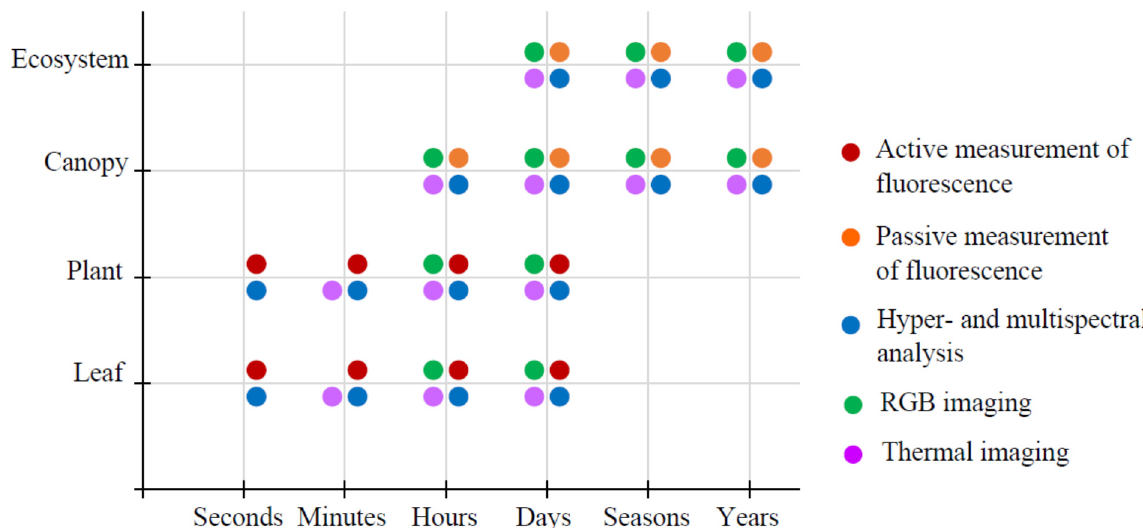
Figure 2. Spatial (from leaf to ecosystem(s)) and temporal (from seconds to years) scales of main optical methods of plant remote sensing. Two types of measurements of the chlorophyll fluorescence are shown: a passive measurement (without fluorescence induction by special measuring light) and an active measurement (with this induction).